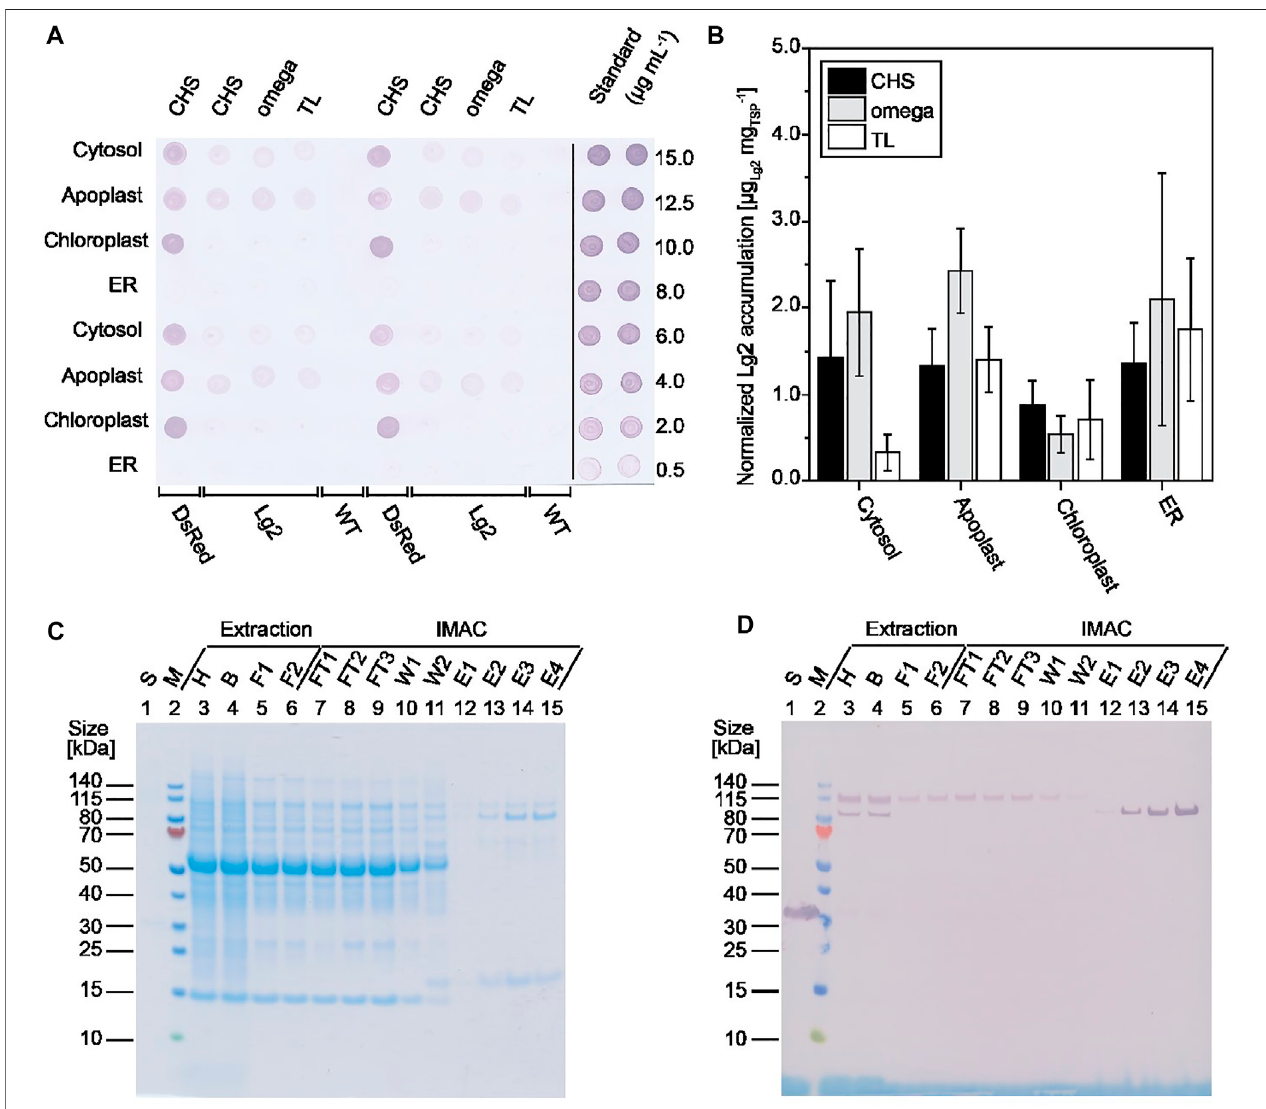
FIGURE 1 | Screening of different Lg2 constructs for expression. (A) Lg2 accumulation in BY-2 PCPs at three dpi as detected by dot blot using a His6-speci fi c primary antibodyand anAP-labeled goat anti-rabbit secondary antibody. (B) Lg2accumulationin N.benthamiana plantsat fi ve dpi based ondensiometric evaluation of dot blots using a His6-speci fi c and AP-labeled antibody, normalized to total soluble protein. Data are means ± standard deviation for n (cid:2) 3 (or n (cid:2) 6 for ER constructs) individual plants. (C, D) Analysis of samples from Lg2 puri fi cation after extraction in 50 mM disodium phosphate, 10 mM sodium bisul fi te, and 500 mM sodium chloride (pH 8.0). Samples were analyzed by LDS-PAGE followed by staining with Coomassie Brilliant Blue (C) or western blot using a His6-speci fi c and AP-labeled antibody (D) . The observed size of puri fi ed Lg2 on the gel and blot ( ∼ 85 kDa) matched the predicted size of 86.7 kDa. B, bag fi ltrate; E, IMAC eluate; F1, PDH4 depth- fi lter fi ltrate; F2, 0.2 µm sterile fi ltrate; FT, IMAC fl owthrough; H, homogenate; S, standard (10 μ g mL − 1 His-tagged DsRed); W1, IMAC wash 1 (20 mM sodium phosphate, 500 mM sodium chloride; pH 7.5); W2, IMAC wash 2 (20 mM sodium phosphate, 500 mM sodium chloride, 15 mM imidazole; pH 7.5); WT, wild-type PCP